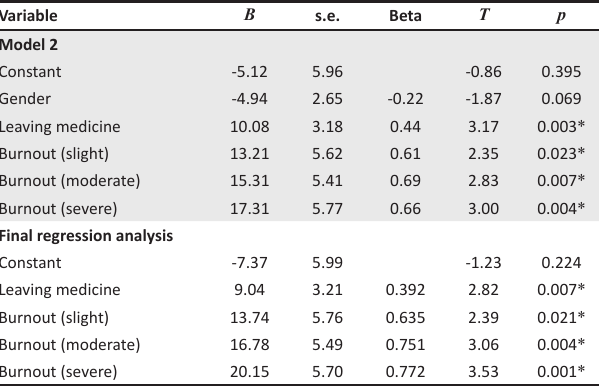
TABLE 4: Table of regression analysis to examine features associated with depression and their Beck Depression Inventory 2 scores.